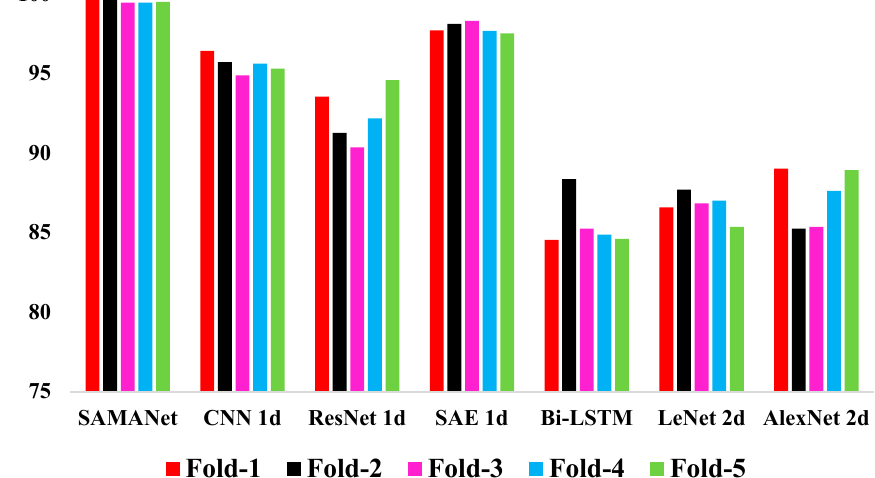
Figure 13. DNNs recognition result (%) 5-fold cross validation comparison. Table 4. Fold-1 accuracy (%) of different DNN models.